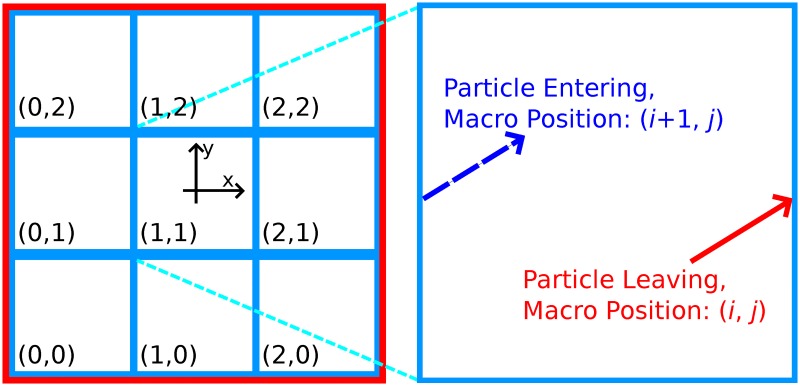
The repeating boundary condition allows the simulation area at the macroscopic level to be broken up into a series of microdomains with (x, y) ∈ [−100 μm, 100 μm]2 (left).Each microdomain contains the same geometry due to the repeating boundary, however each track stores the identity of its current macroscopic domain, here labeled in the bottom right of each small cube. When a particle leaves a microdomain (right), it re-enters at the other side, due to the periodic boundary. When this occurs, the track updates its stored position in the macroscopic view.